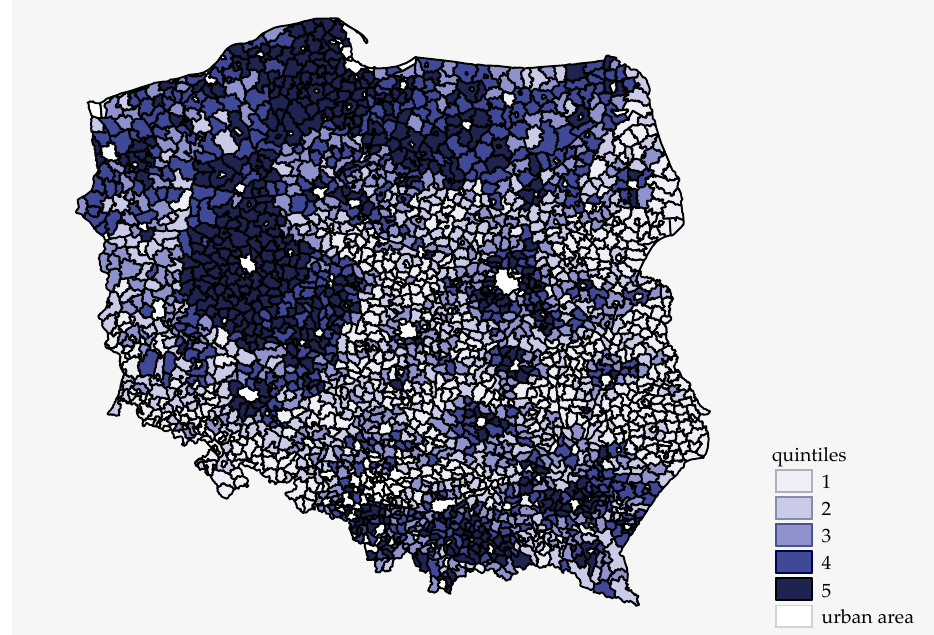
Energies 2022 , 15 , x FOR PEER REVIEW 19 of 32 Figure 4. Human capital in the area of health—[HCH] synthetic measure. Source: own elaboration.